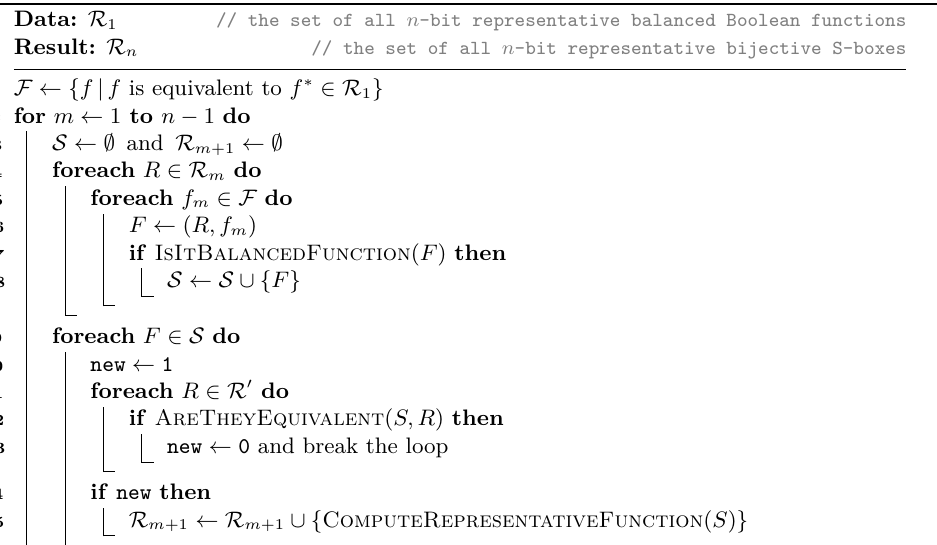
Algorithm 4: The previous method of building n -bit bijective S-boxes in [Can07]. Data: R